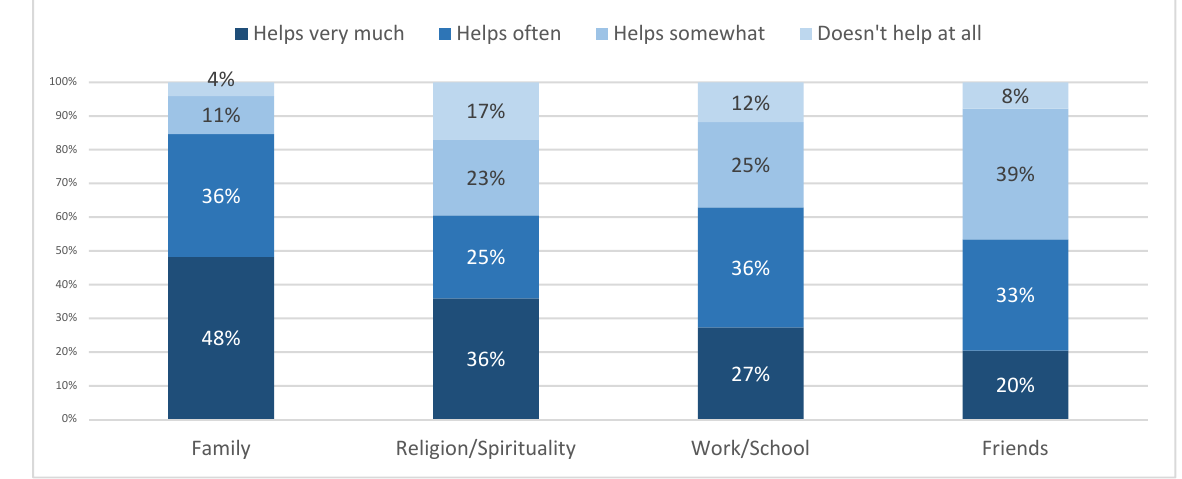
Figure 3. Giving meaning to life during COVID-19, by percentage.